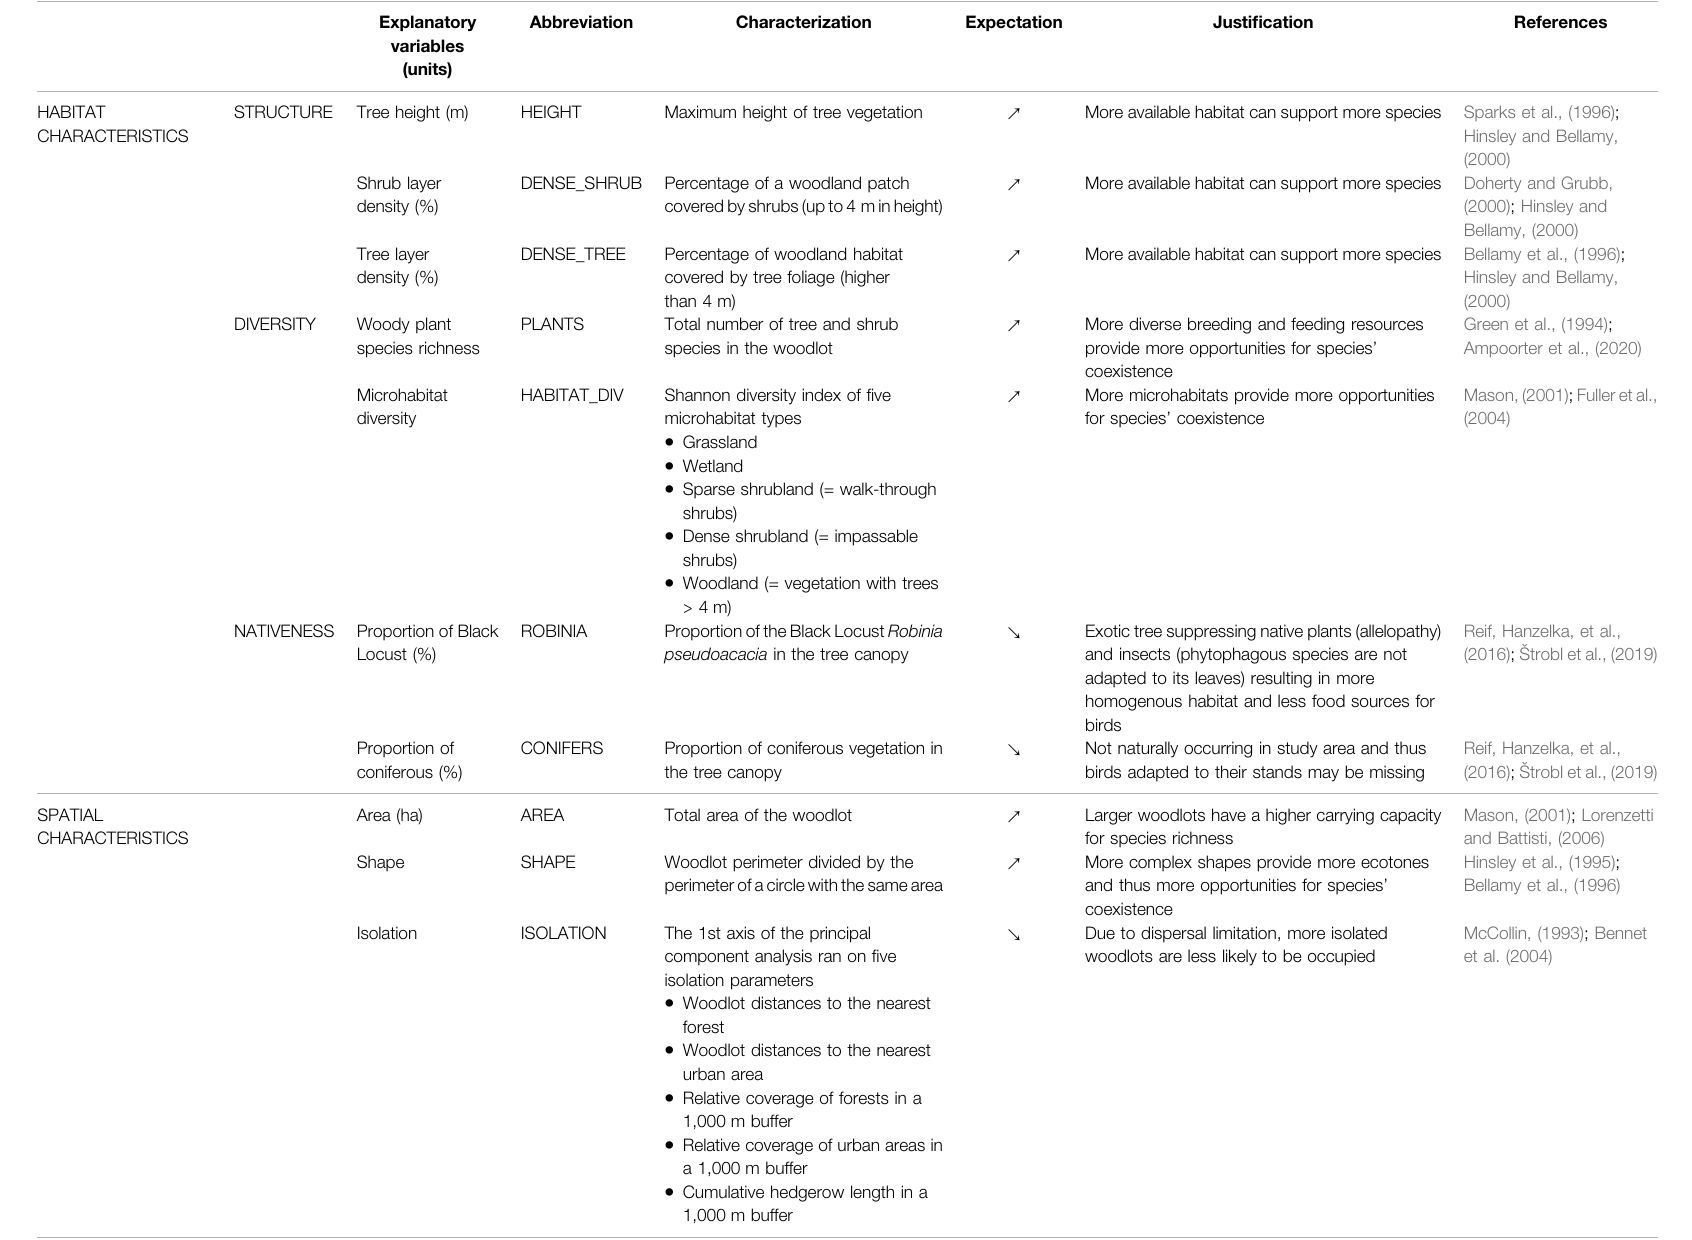
TABLE 1 | Variables describing habitat and spatial characteristics of woodlots and their expected relationships with bird species richness ( b stands for positive and a for negative